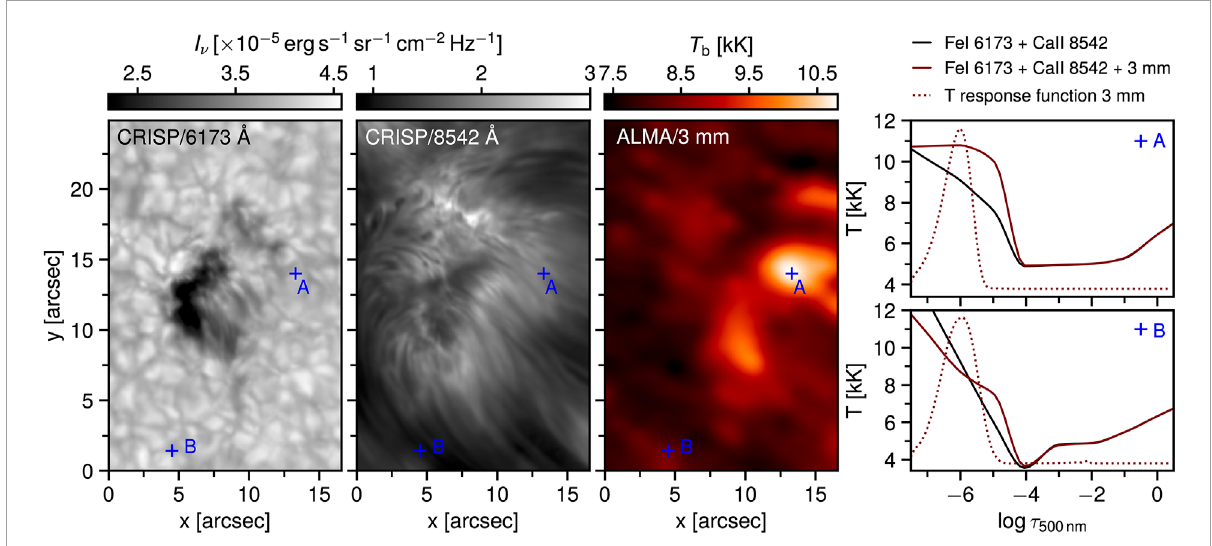
FIGURE 5 NLTE inversions of SST/CRISP and ALMA observations of an active region (da Silva Santos et al., 2022a). From the left to the right: intensities in the continuum at 6173 Å and in the core of the CaII 8542 Å line, ALMA band 3 brightness temperature map, temperature as a function of the logarithmic optical depth (solid lines) derived from CRISP and CRISP + ALMA inversions at the locations A and B, and temperature response functions at 3 mm in arbitrary units (dotted lines) for the CRISP + ALMA